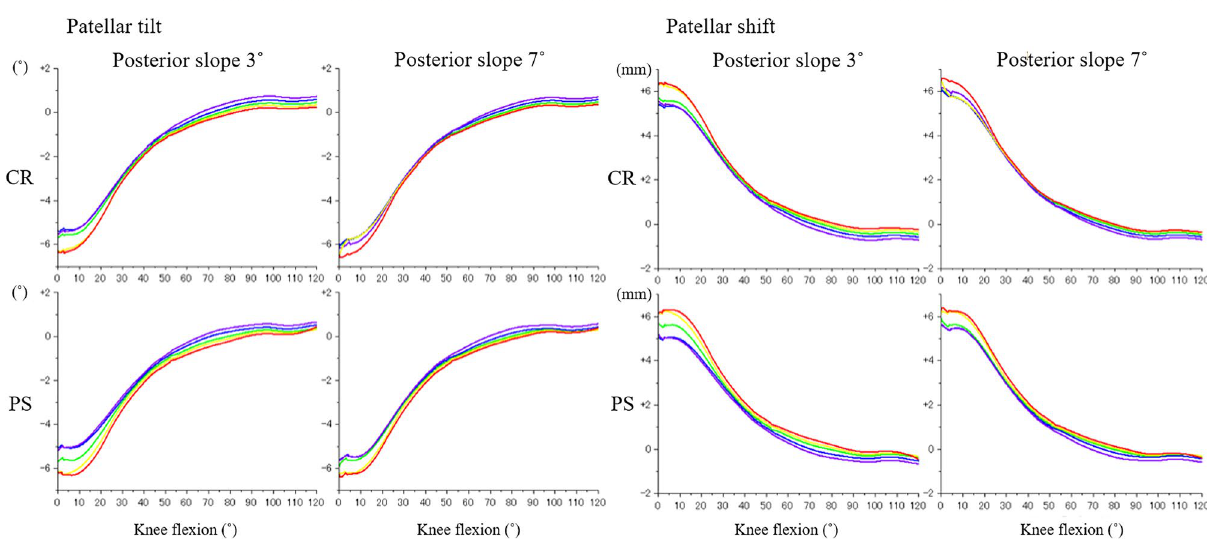
Figure 7. Patellofemoral kinematics during knee flexion. CR cruciate-retaining design, PS posterior-stabilized design. Comparison between the tibial rotational alignments (red: internal 10°, yellow: internal 5°, green: neutral, blue: external 5°, purple: external